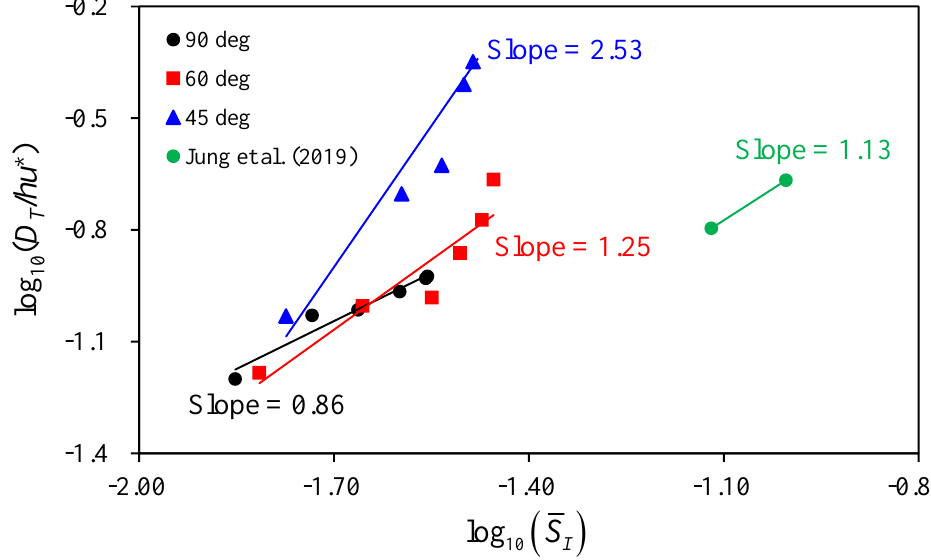
S and dimensionless transverse dispersion coefficient [21]. Figure 12. Relations of S I and dimensionless transverse dispersion coefficient Figure 12. Relations of I